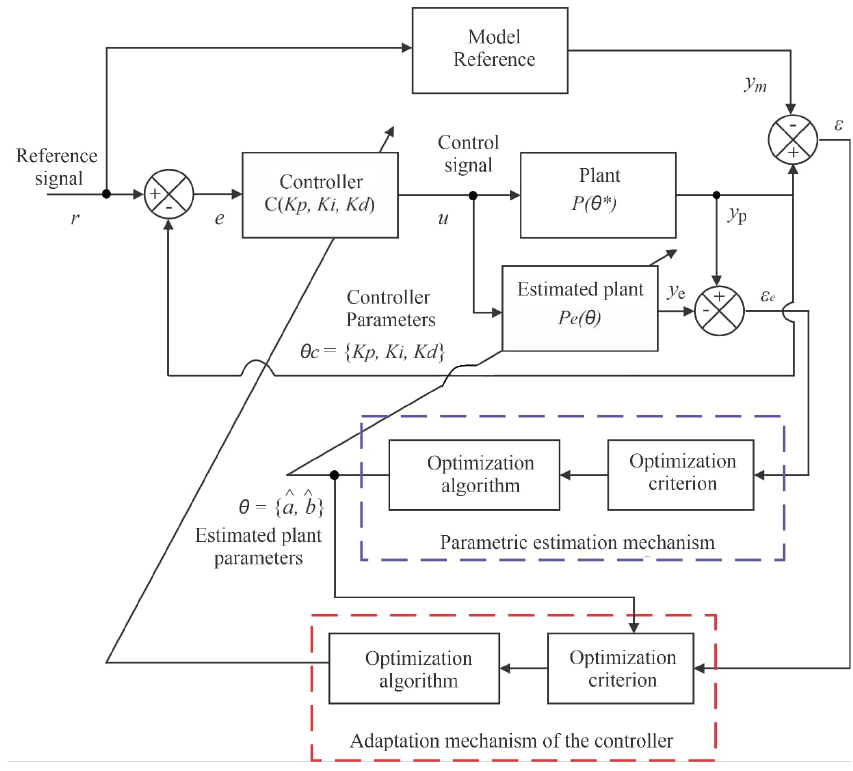
Figure 7. IMRAC ‐ PID block diagram [4]. Figure 7. IMRAC-PID block diagram